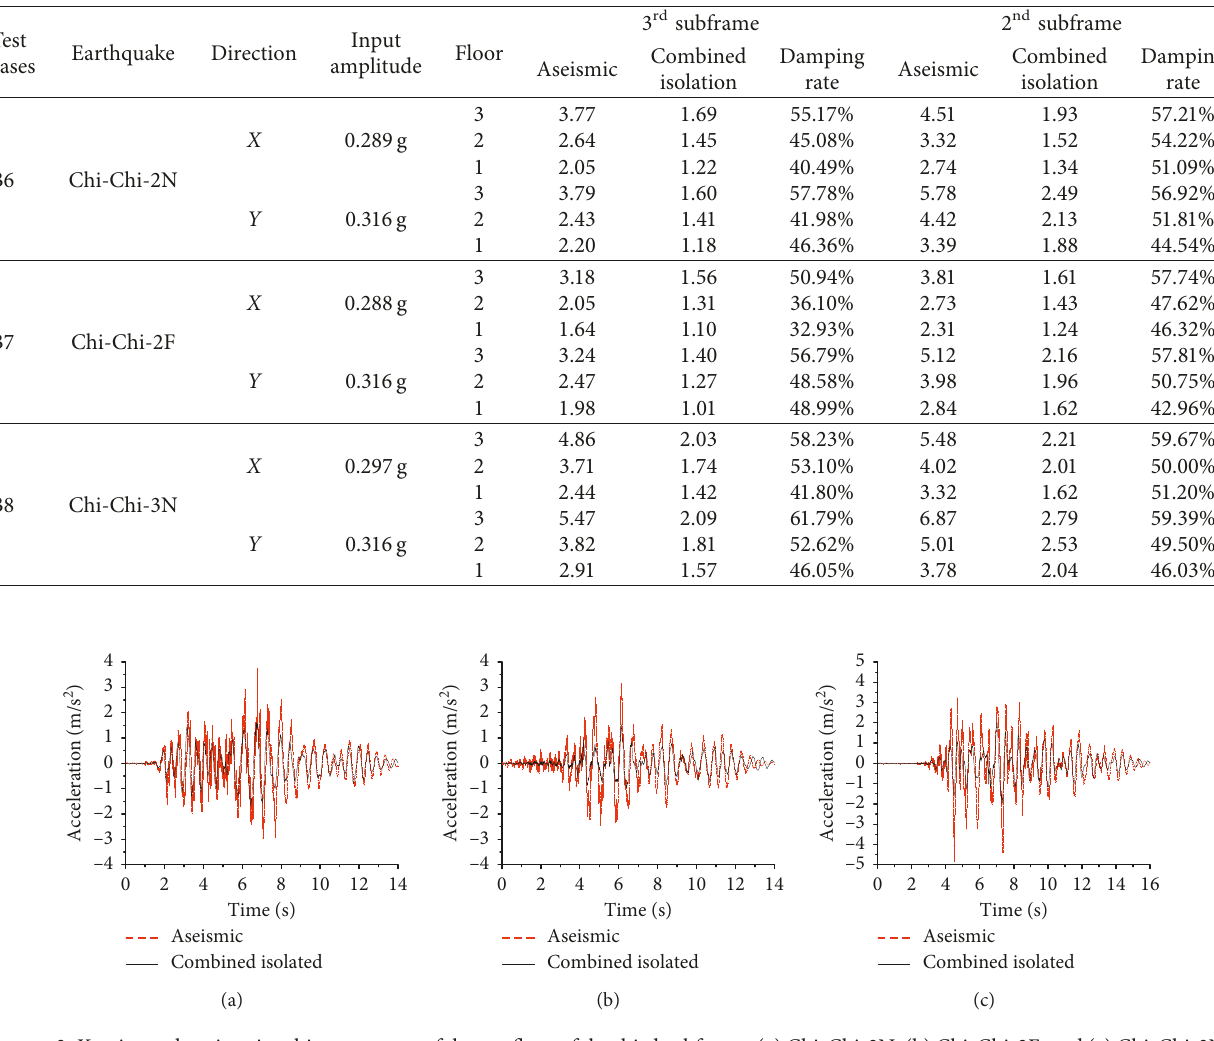
Figure 3: X -axis acceleration time history curves of the top floor of the third subframe. (a) Chi-Chi-2N, (b) Chi-Chi-2F, and (c) Chi-Chi-3N.